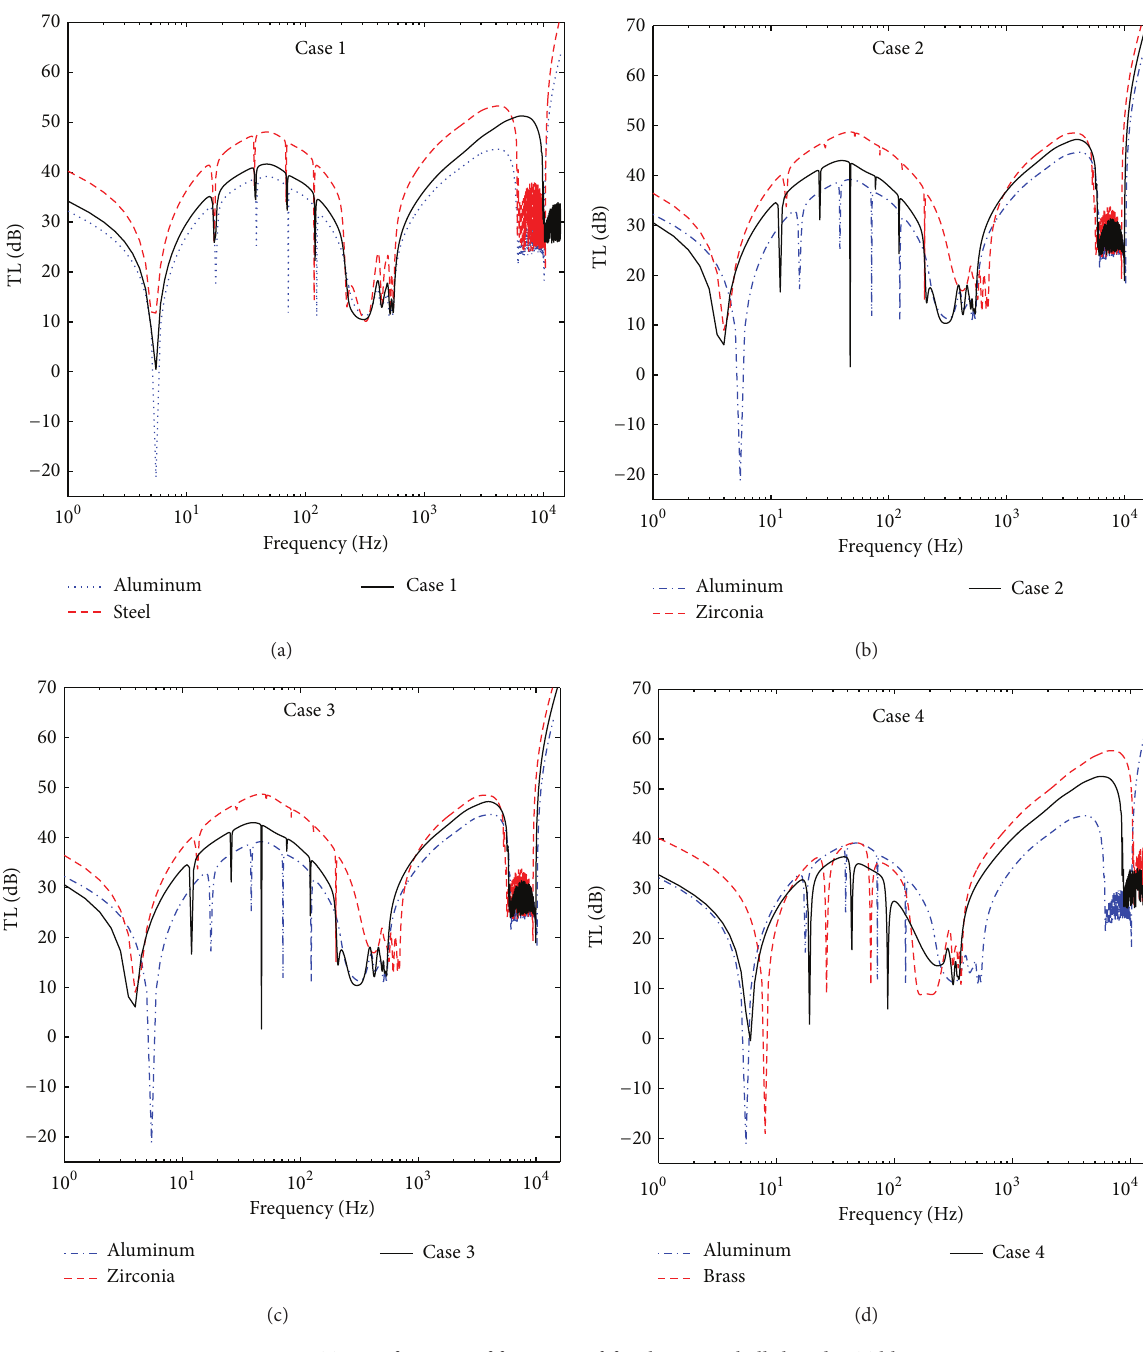
Figure 4: TL as a function of frequency 𝑓 for the FGM shells listed in Table 4.